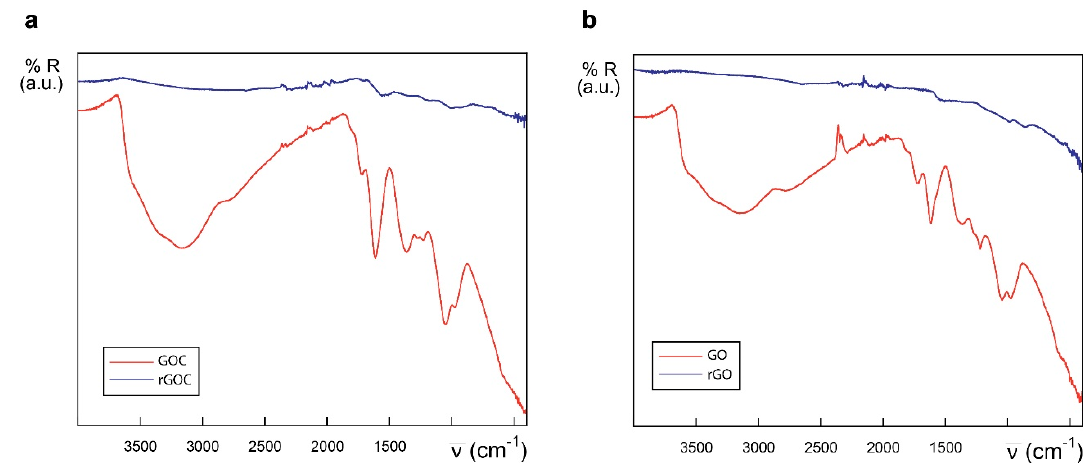
Figure 10. IR spectra of GOC and rGOC ( a ) and GO and rGO ( b ) in the 4000–400 cm − 1 region.